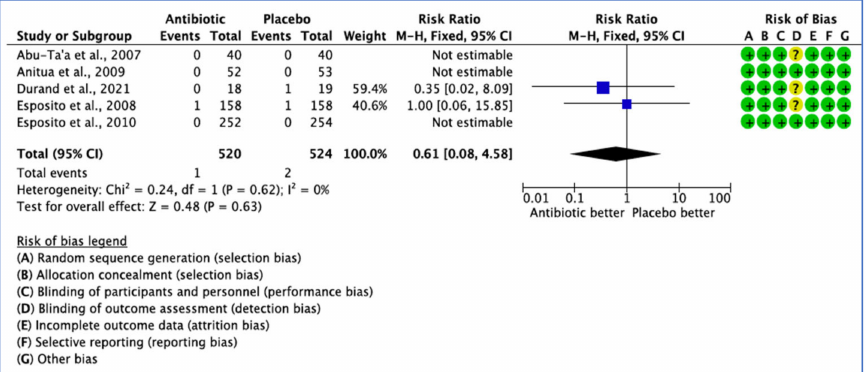
Figure 6. Forest plot of comparison between AB and placebo, which gives the summary estimate (centre of diamond) and its 95% confidence interval CI (width of diamond) based on postoperative adverse events. Statistical method: Mantel-Haenszel with fixed effect model